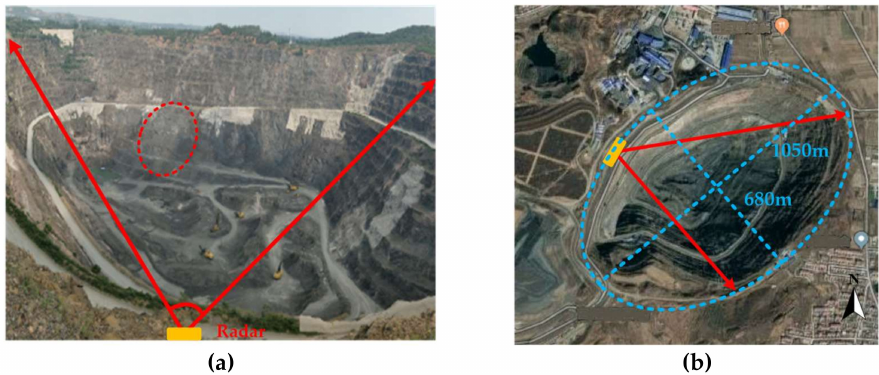
Figure 1. ( a ) Photo of the open-pit mine. ( b ) Top view from the Google satellite map.